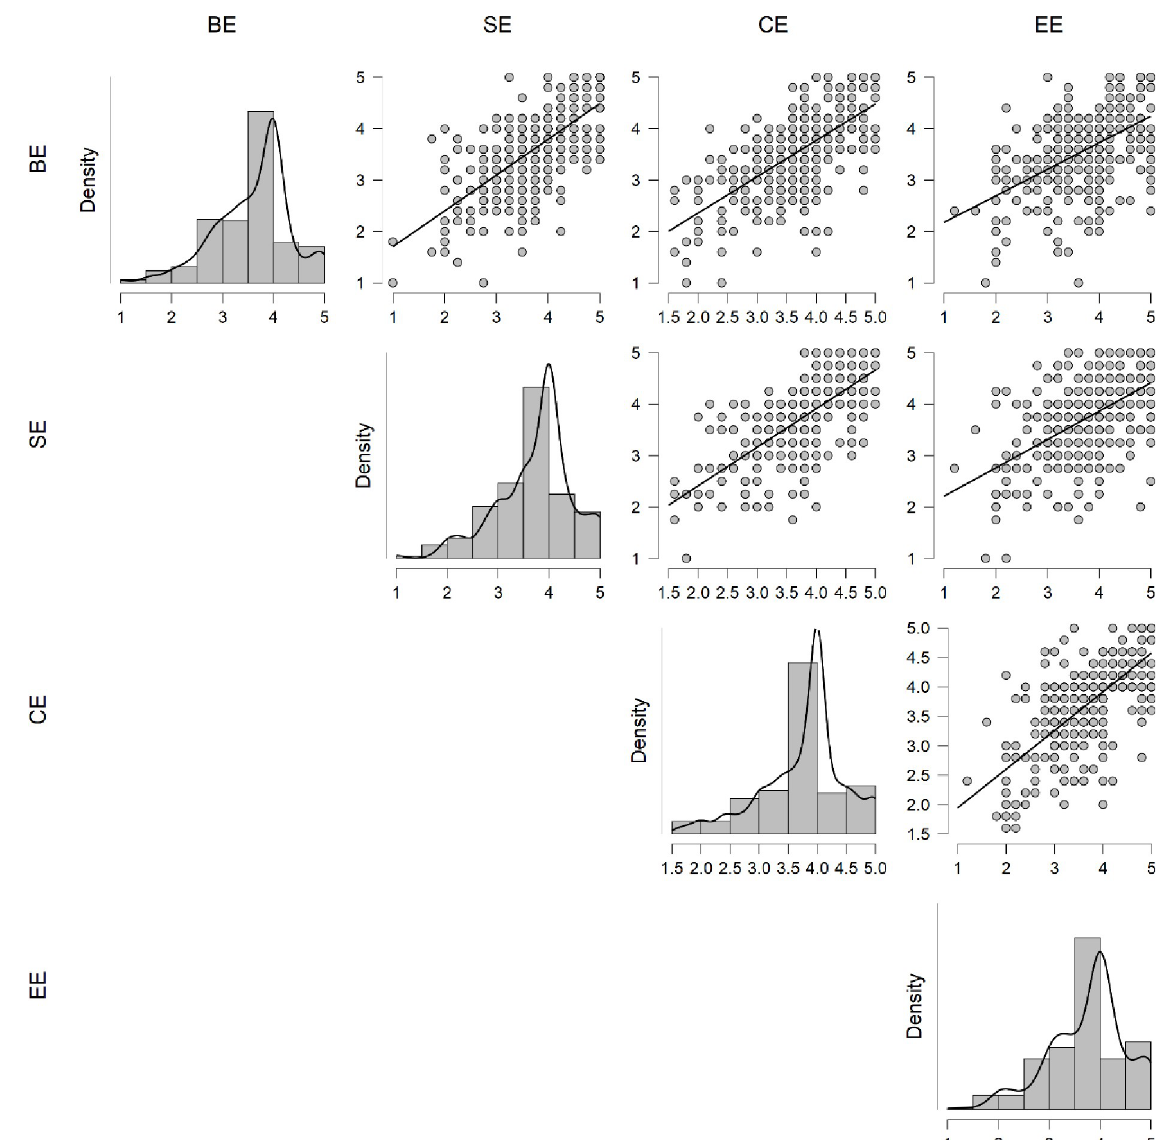
Fig 3. Correlation plot based on the four dimensions.